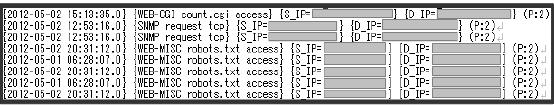
Figure 7: Detailed information on